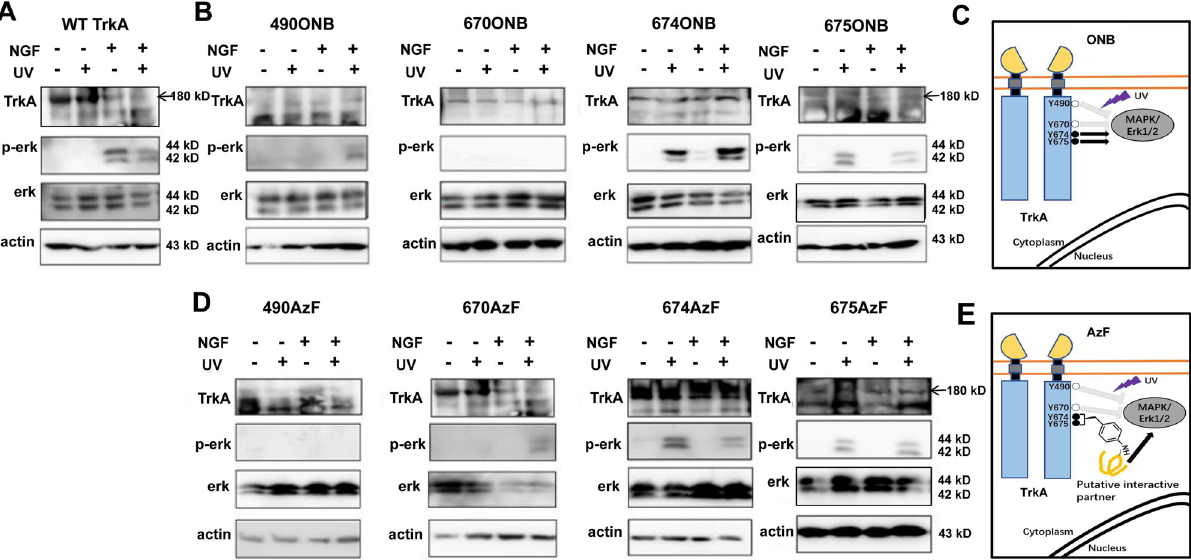
Fig. 5 UV light activates MAPK/ERK signaling pathway independent of ligand NGF. Western blot analysis of HEK293T cells expressing wt-TrkA ( a ), ONB mutants ( b ) including TrkA-Y490ONB, TrkA-Y670ONB, TrkA-Y674ONB, TrkA-Y675ONB, and AzF mutants ( d ) including TrkA-Y490AzF, TrkA- Y670AzF, TrkA-Y674AzF, TrkA-Y675AzF; without ( − ) or with ( + ) NGF, and without ( − ) or with ( + ) UV light. TrkA and β -actin were used as loading control. In the absence of ligand NGF, ONB ( c ) or AzF ( e ) incorporated at the Y674 and Y675 (solid circles) sites in TrkA, respectively, after UV treatment initiate intracellular MAPK/ERK signaling (arrows). In the case of AzF, the signaling activation is presumably due to photo-cross-linking of an interactive protein in the MAPK/ERK signaling complex. ONB ( c ) or AzF ( e ) incorporated in Y490 and Y670 (empty circle) site does not initiate intracellular MAPK/ ERK signaling (inhibited